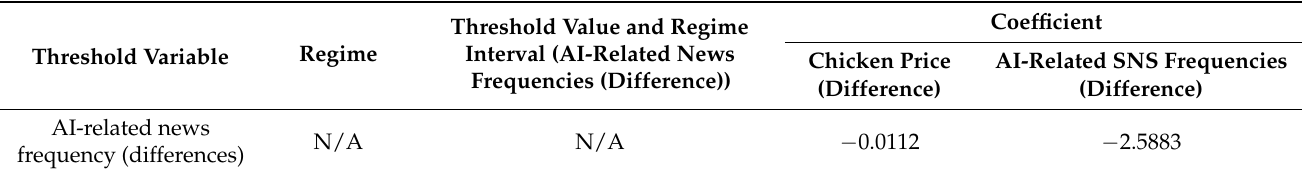
Table 7. Autoregressive Model of the Avian Influenza (AI)-related News Frequency for Retail Chicken Prices.